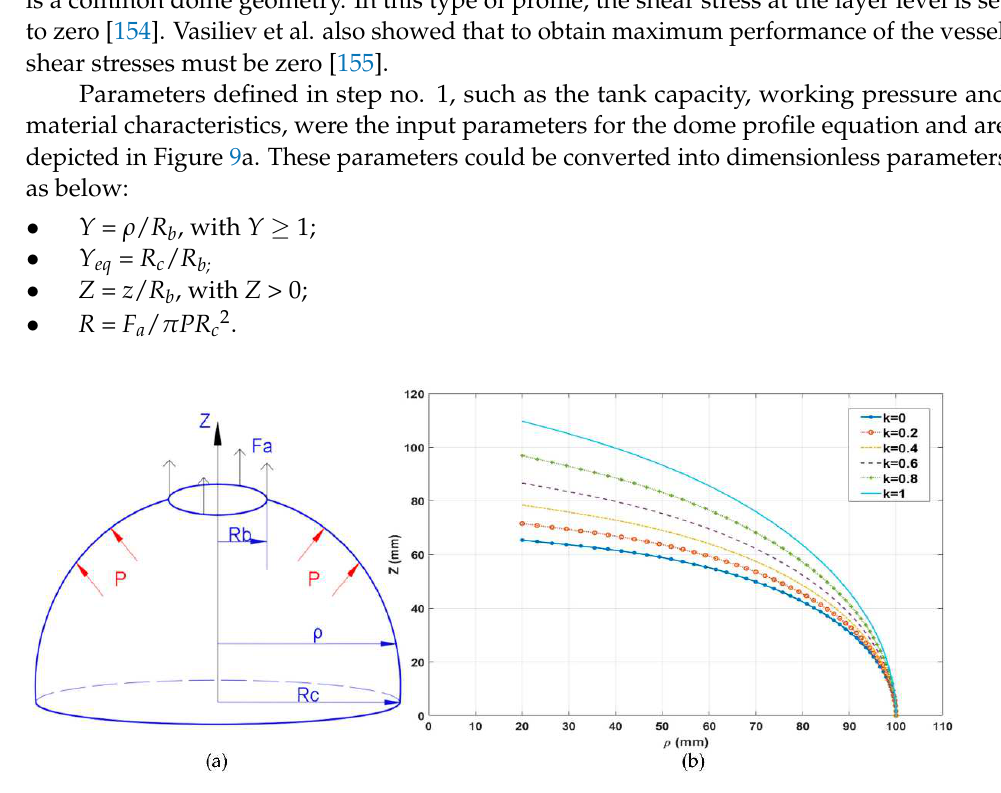
Figure 9. Dome design: ( a ) schematic representation of dome; ( b ) isotensoid dome contour generated with numerical